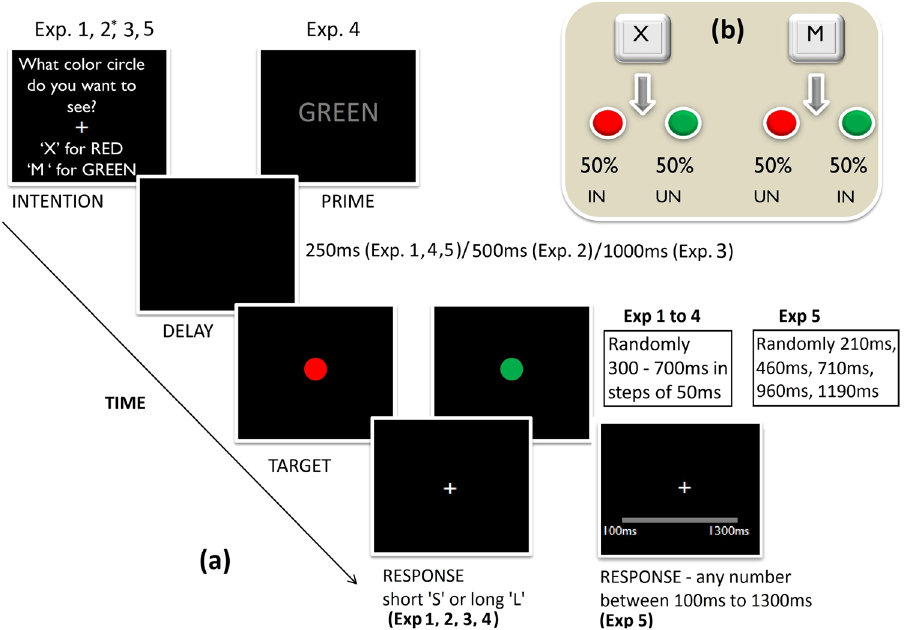
Figure 2. Experimental design. ( a ) Trial structure used in all the experiments. ‘ * ’ Indicates the experiment involved yellow and blue color circles instead of red and green. Before each trial participants selected what color circle they wanted to see by pressing the pre-assigned keys. The outcome appeared after a fixed delay in each experiment, but varied across the experiments [ 250 ms in Exp 1, Exp 4, Exp 5; 500 ms in Exp 2; 1000 ms in Exp 3]. Randomly on half of the trials participants received the intended outcome and on the other half the unintended outcome. In Exp4, the participants had no choice but were forced to press the key based on the presented word, in this case on half of the trials the word matched the color of the circle (congruent), and on other half it did not match (incongruent). In Exp1, 2, 3 and 4 temporal bisection task was used, the target circle appeared for a variable duration (from 300 ms to 700 ms in steps of 50 ms), and participants reported the duration as either close to short (press ‘s’) or long (press ‘l’) anchor duration. In Exp5, a verbal estimation task was used, the target circle appeared for a variable duration (210 ms, 460 ms, 710 ms, 960 ms, 1190 ms), and participants used the computer mouse to report the estimated duration in the range of 100 ms to 1300 ms. ( b ) Distribution of intended and unintended